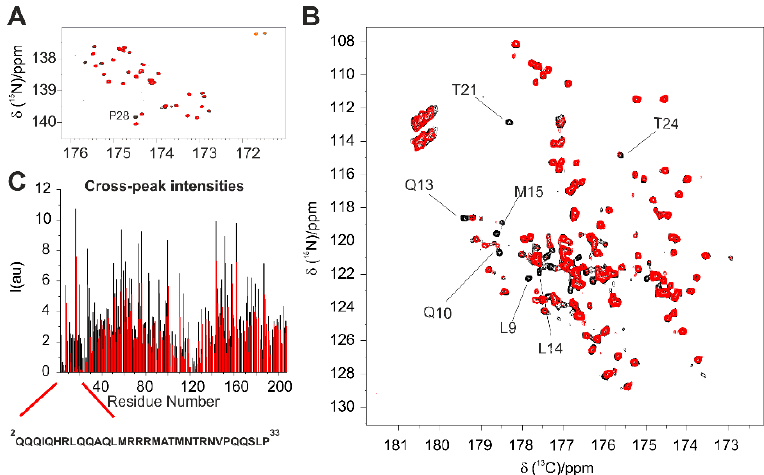
Figure 7. ( A ) Comparison of 2D H α -CON pro spectra of CBP-ID4 (black) and CBP-ID4:E1A12S 1:1 (red); ( B ) comparison 2D H N -CON spectra of CBP-ID4 (black) and CBP-ID4:E1A12S 1:1 (red). The assignment of selected peaks is also reported. ( C ) Comparison of cross-peak intensities in 2D H N -CON and 2D H α -CON pro experiments for CBP-ID4 in the isolated form (black) and CBP-ID4:E1A12S 1:1 complex (red). All the spectra were acquired at 283 K with a 16.4 T Bruker Avance NEO NMR spectrometer equipped with a 13 C TXO CryoProbe TM .